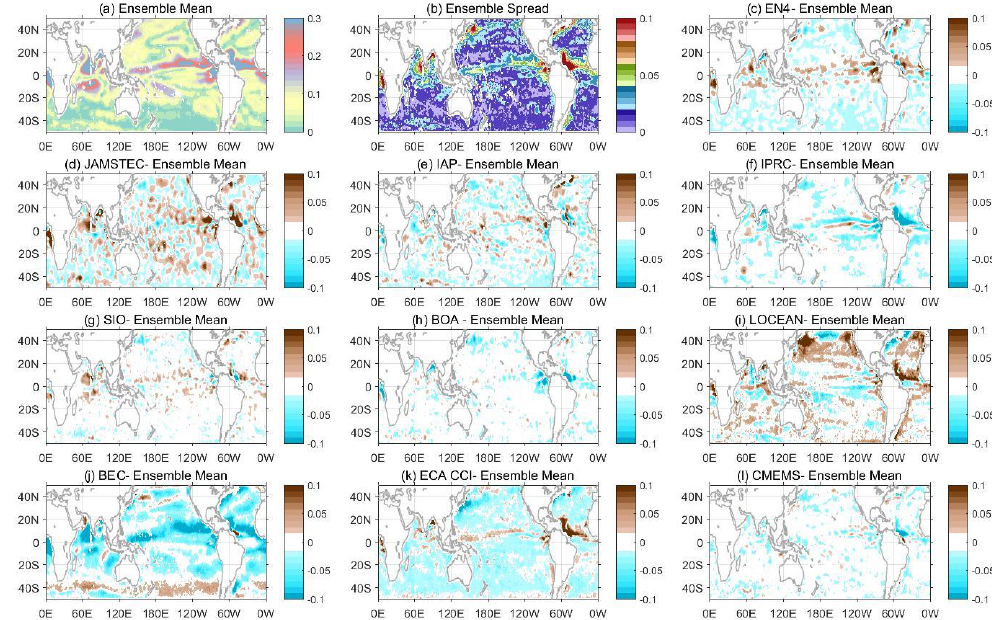
Figure 8. ( a ) The STD of the ensemble mean of annual SSS. ( b ) The spread of the STD of the annual SSS time series based on ten products. ( c – j ) The difference between the STD of the annual SSS signal from individual products and the ensemble mean. The blue lines in ( a – l ) denote the major rivers worldwide.